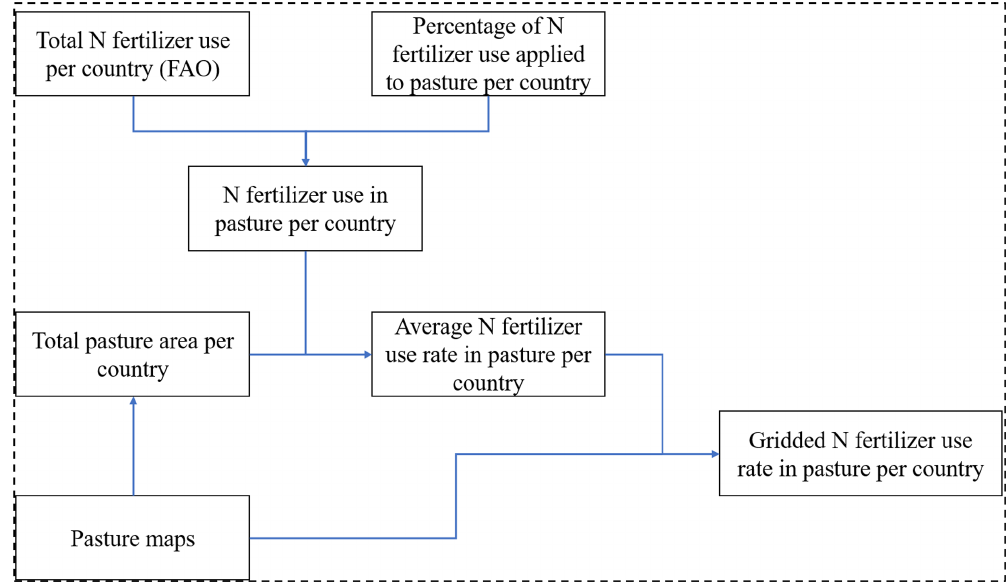
Figure 2. The workflow for developing the global pasture fertilizer application rate data for the period from 1961 to 2019.